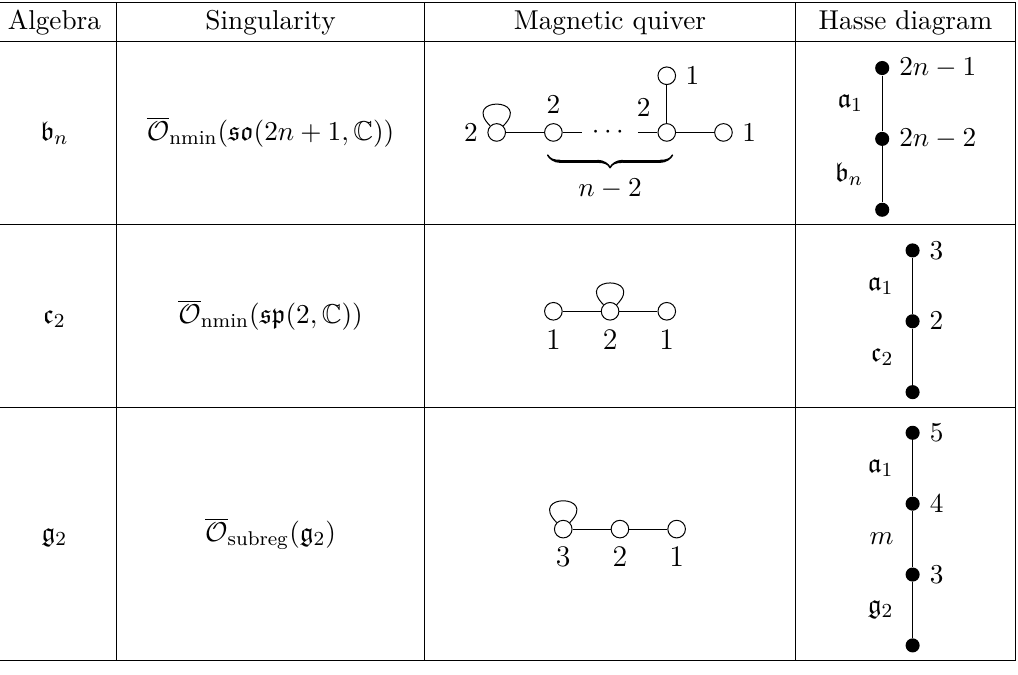
Table 7 . Summary of non-simply laced symplectic leaves and their magnetic quivers. The quivers for the closure of the next-to-minimal orbit of b is obtained from the quiver for the closure of n the minimal nilpotent orbit of d after S wreathing acting on the two spinor nodes, which can n +1 2 be depicted equivalently by an adjoint hyper. The c quiver is obtained by identification with the 2 b 2 quiver. Finally the g 2 quiver is obtained from S 3 wreathing of the d 4 closure of the minimal nilpotent orbit quiver. Note that the closures of next-to-minimal nilpotent orbits of the other non- simply laced algebras c and f are also available in terms of wreathed quivers, but the wreathing n 4 acts on more than u (1) nodes, so they can not be rephrased as quivers with adjoint